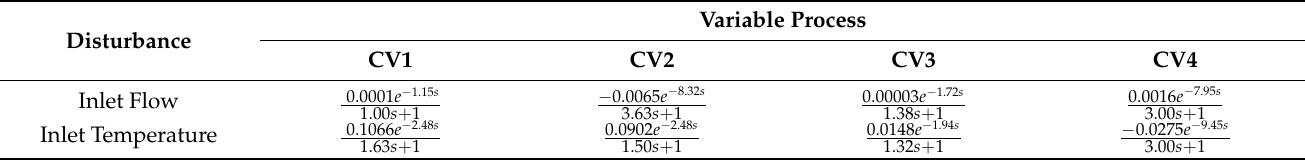
Figure 4. PRC of methanol purification controlled variables after the addition of ( a ) feed-in flow disturbance and ( b ) feed-in temperature disturbance. Table 7. FOPDT of the methanol purification disturbance